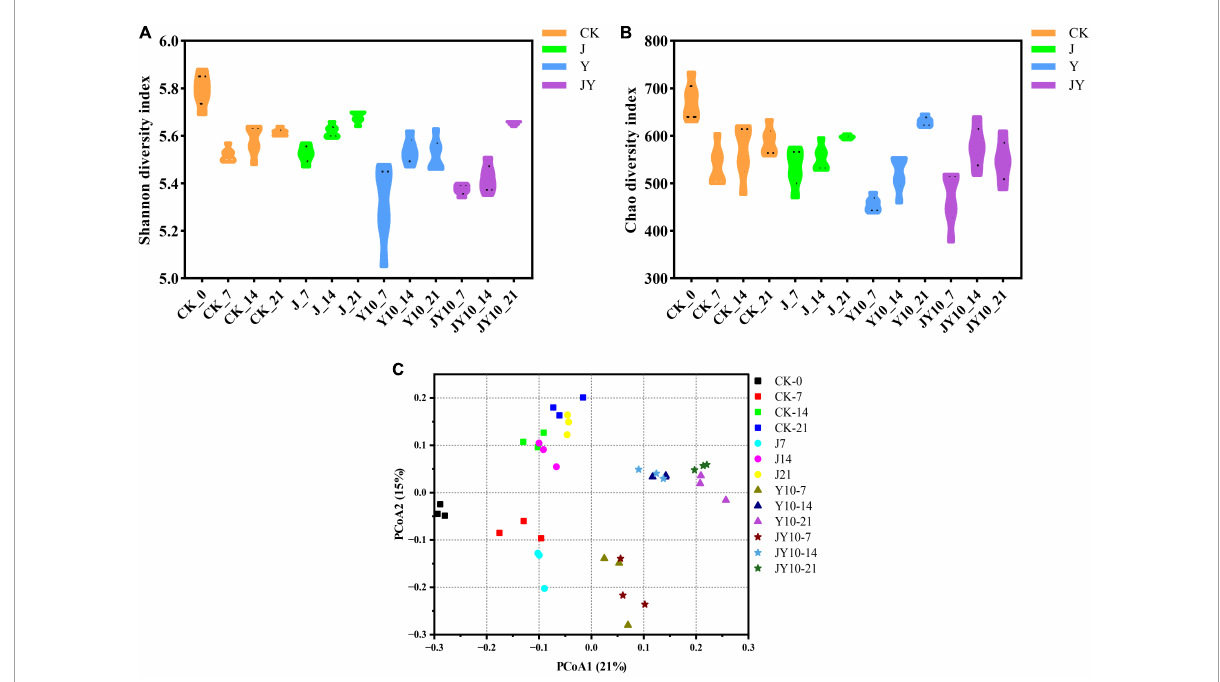
FIGURE7 Alpha diversity and Beta diversity analysis of soil microbial community structure under different treatments. (A) Shannon diversity index for microbial communities of different treatments. (B) Chao diversity index for microbial communities of different treatments. (C) Analysis of the differences between different samples with same treatment condition. CK, no lactofen and solid agents; J, solid agents; Y, lactofen; JY, lactofen and solid agents. Among them, Y10 means 10 mg/kg lactofen, JY10 means 10 mg/kg lactofen and solid agents. The numbers 7, 14, and 21 represented the days of administration, respectively. The Shannon index comprehensively considered the richness and evenness of the community. The larger the Shannon value was, the higher the community diversity was. The Chao index reflected the richness of the community by estimating the number of species in the community, and the larger the index was, the higher the community richness was. PCoA, which could be used to study similarities or differences in sample community composition.